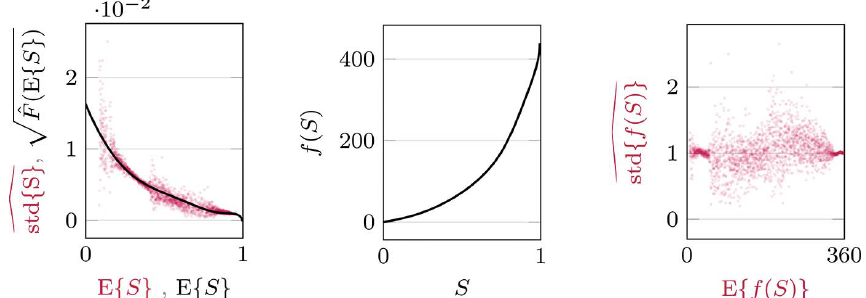
Figure 2 Illustration of the variance stabilization of Fly . Left: scatterplot of the sample standard deviation of S (red) as well as the square root of a polynomial approximation ^ FF of F (black), computed on S scaled to the range [0, 1] as a function of its expectation using a fifth-degree polynomial variance model. Middle: the variance stabilizing transformation f for this ^ FF . Right: sample standard deviation of f ( S ) as a function of its expectation. The standard deviations and f are both computed using Foi (2009) and Azzari & Foi (2014). Every point of the red scatterplot corresponds to the sample mean and sample standard deviation of a narrow segment of the image; the dispersion of the scatterplot is due to the finite sample size of each